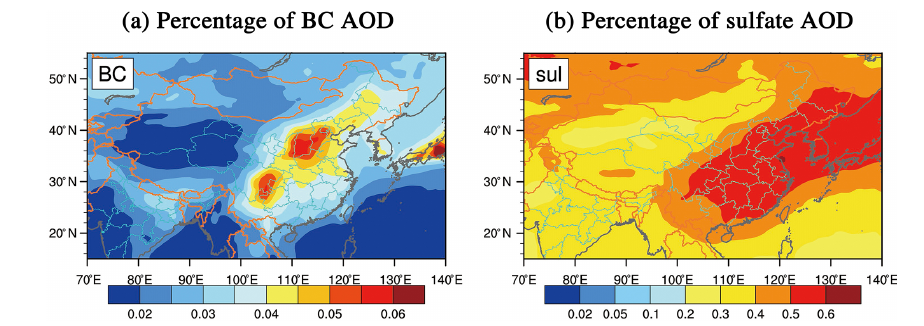
Figure 5. Percentages of AOD for (a) BC and (b) sulfate from MACC reanalysis data in summers (June–August) during 2002 to